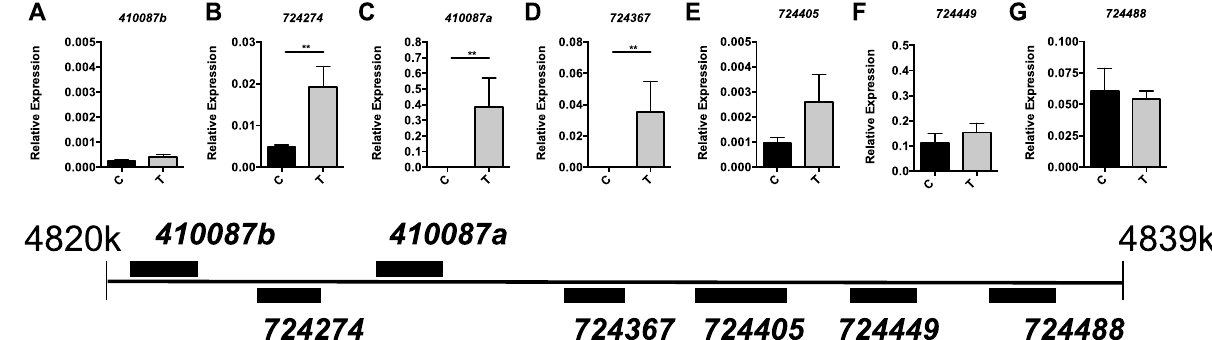
Figure 2. Select sHSP genes are induced during UPR induction. Transcript levels of the l(2)efl genes 410087b ( A ), 724274 ( B ), 410087a ( C ), 724367 ( D ) , 724405 ( E ), 724449 ( F ), and 724488 ( G ) relative to β-actin in midgut tissue from adult bees captured at the landing board and fed sucrose solution containing tunicamycin (T, n = 8) or vehicle alone (C, n = 8) for 24 h. A schematic diagram of the colocalized l(2)efl genes in the honey bee genome is shown below for reference. Mean ± SEM is shown and represents expression values of the genes of interest calculated using the 2 (−ΔCT) method for individual bees. Statistical significance is noted as *p < 0.05, and **p < 0.01.